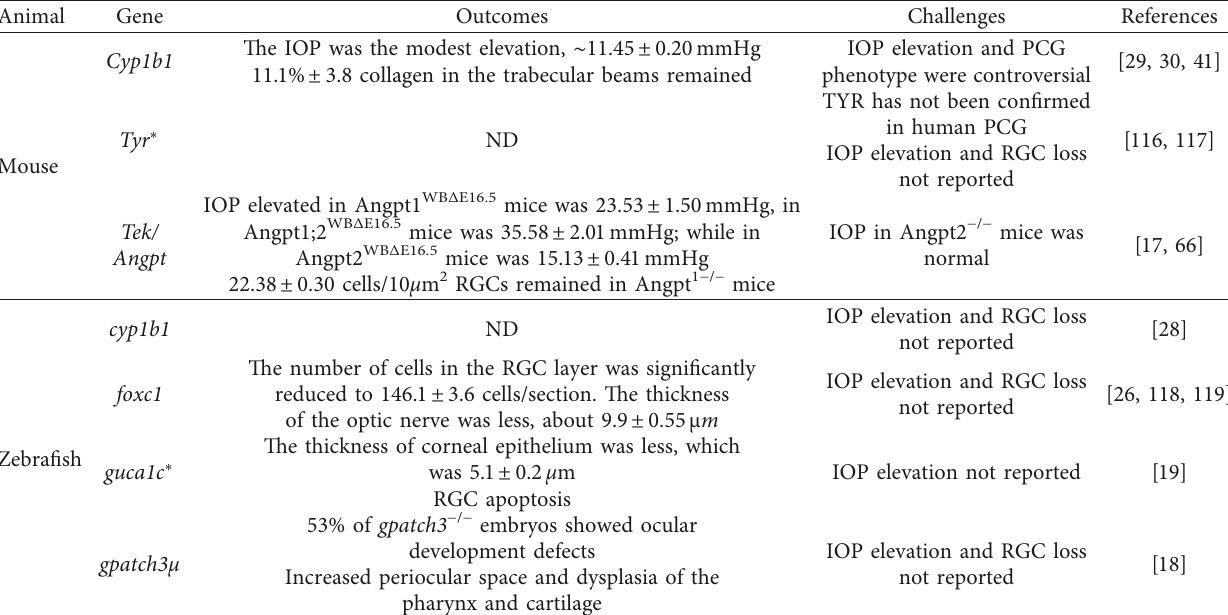
Table 3: Pathogenic genes of human PCG confirmed in the genetic model. Animal Gene